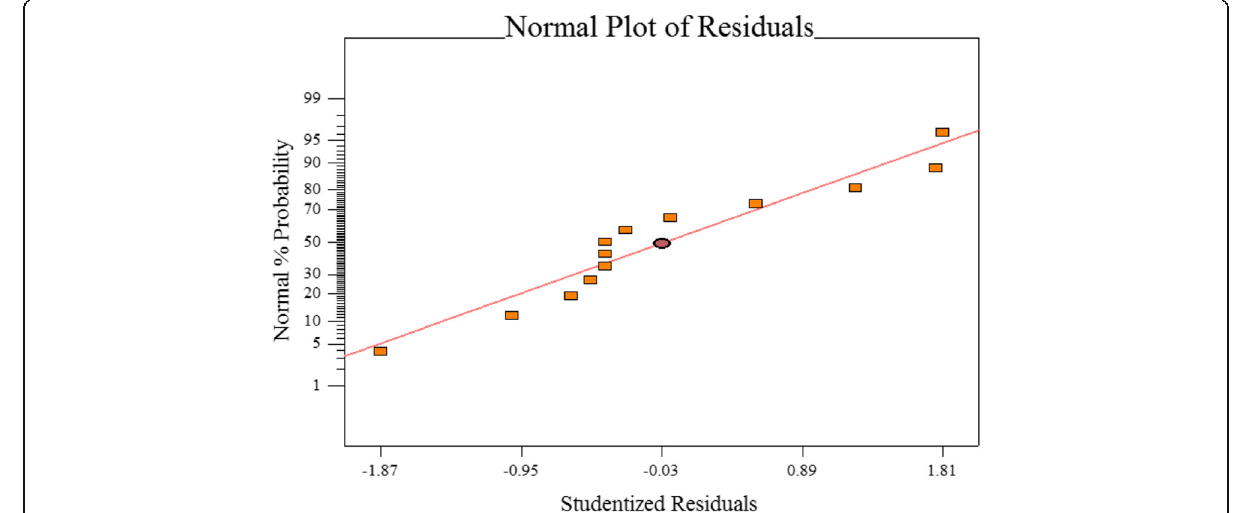
Fig. 1 The normal plot of residuals of astaxanthin model